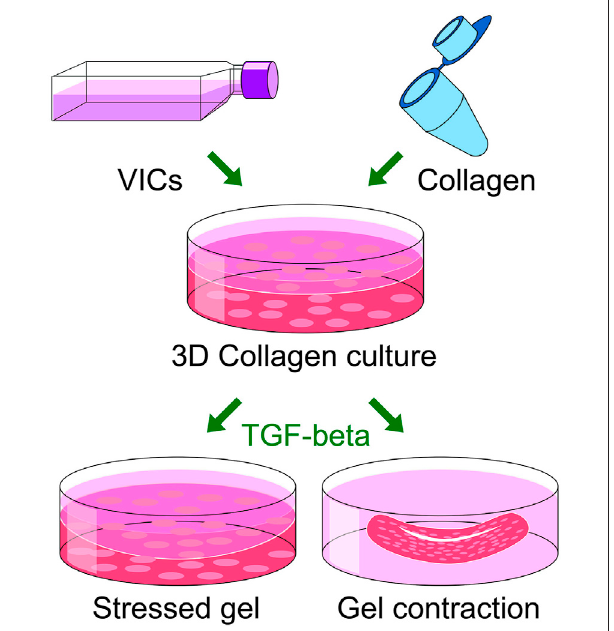
FIGURE 7 | A schematic overview of two 3D cell culture system (stressed gel and gel contraction), based on collagen gel that are being used for measuring the contractility of VIC-derived myo fi